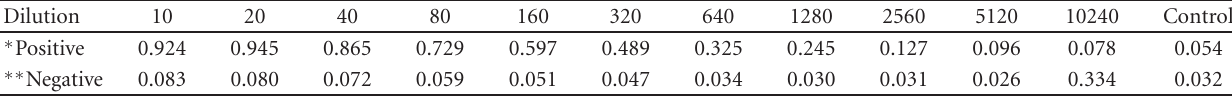
Table 1: OD 650 values of preliminary ELISA for detection of positive NS1 recombinant protein.